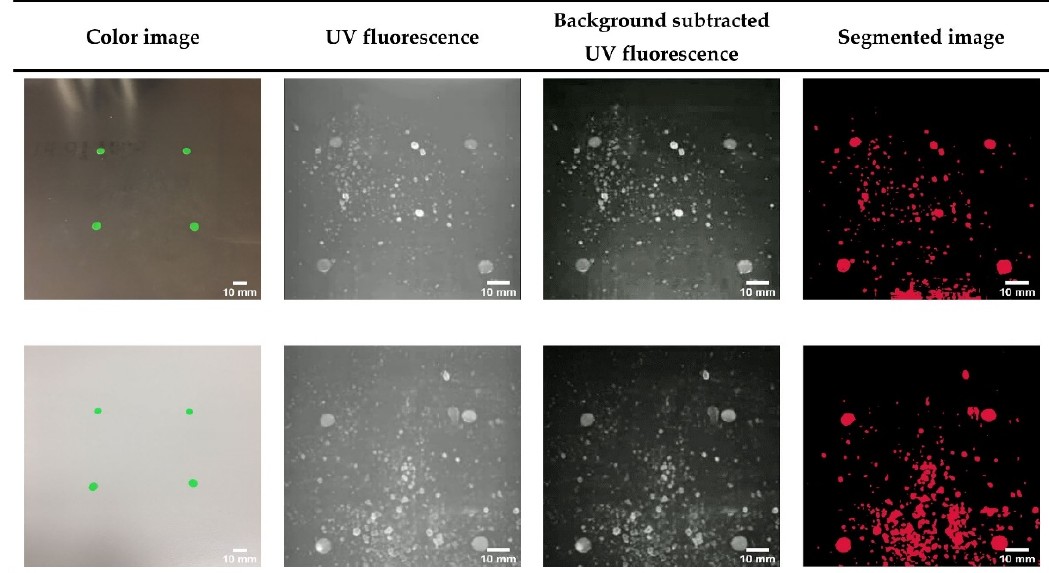
Figure 3. Images from the CSI-D system show saliva and respiratory droplets on stainless steel (top row) and plastic (bottom row). The smartphone color image column shows the green fluorescence paper dots affixed to the steel and plastic surfaces. The UV fluorescence column shows the images captured by the CSI-D UV camera. The background subtracted UV fluorescence column shows the UV image after background subtraction. The segmented image column shows the image segmentation mask after applying the adaptive thresholding algorithm. The fluorescent dots seen in the color image can be easily identified in the UV fluorescence image even with different fields of view. The scale bar for all images is set to 10 mm.